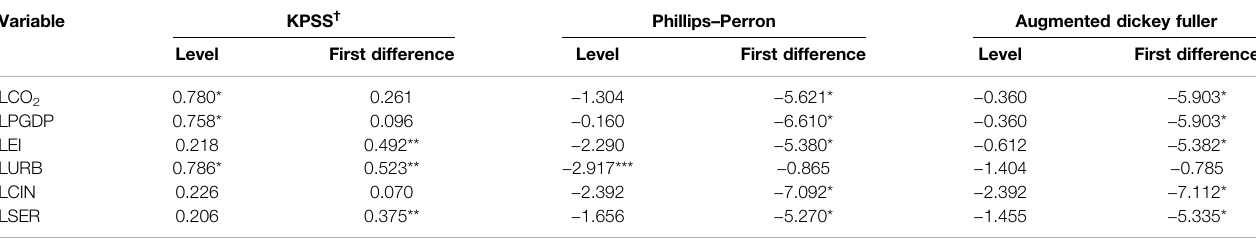
TABLE 2 | Estimated results for the Unit root test at the level of the variable.